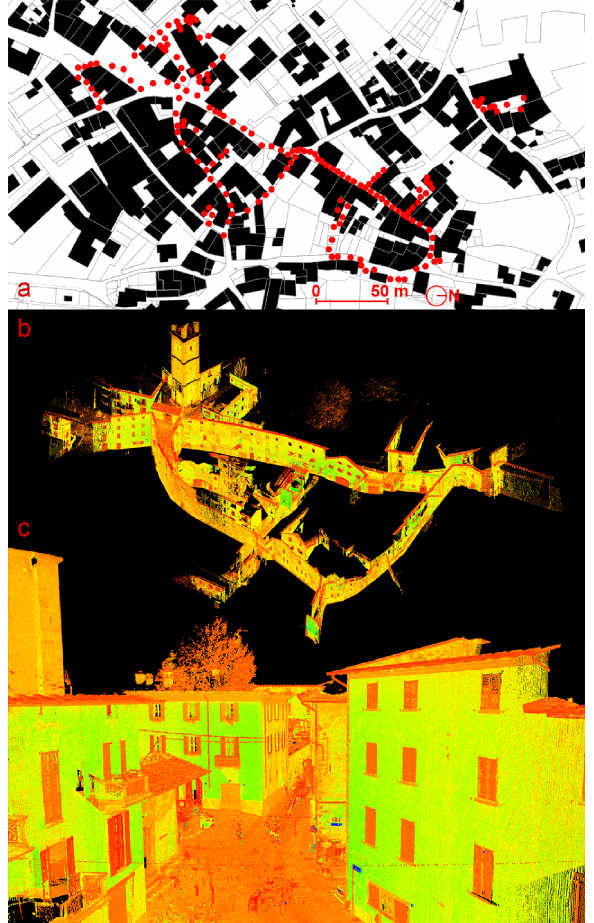
Figure 4. (a) Map of Chiuro with scan locations. (b-c) Views of some registered